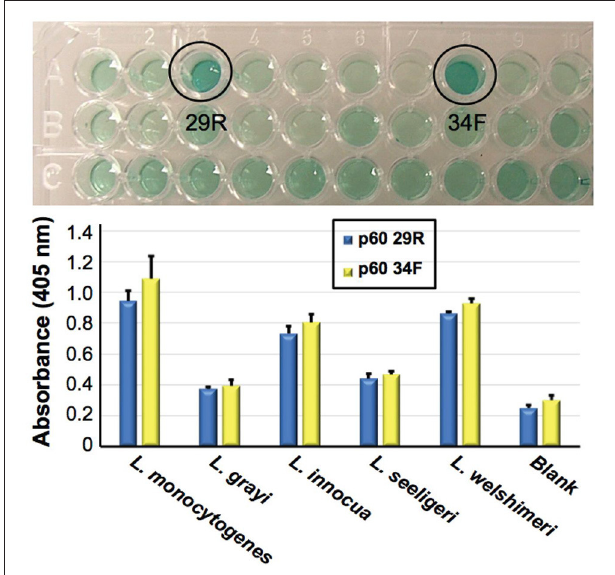
FIGURE 4 | Identification of two candidate aptamers which were selected to bind Listeria monocytogenes specific peptide epitope (QQQTAPKAPTE). Top—initial ELISA-like (ELASA) screening assay results, which identified p60 29R and 34F as the best or highest affinity aptamers for binding to the peptide. Bottom—ELASA results for these two aptamers vs. a variety of Listeria species. Both aptamers exhibited a preference for binding to immobilized L. monocyogenes whole viable cells. Bar heights and error bars represent the Means ± 2 Standard Deviations of six independent ELASA readings ( Bruno and Sivils,